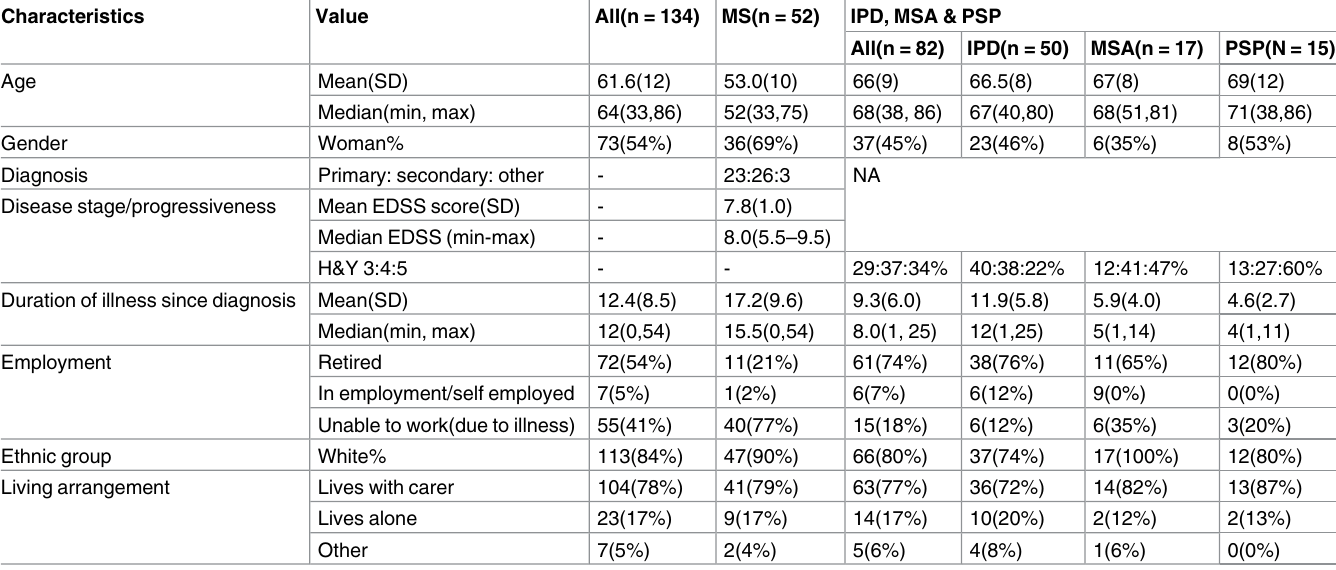
Table 1. Demographic and clinical characteristics in MS and IPD, MSA & PSP samples.